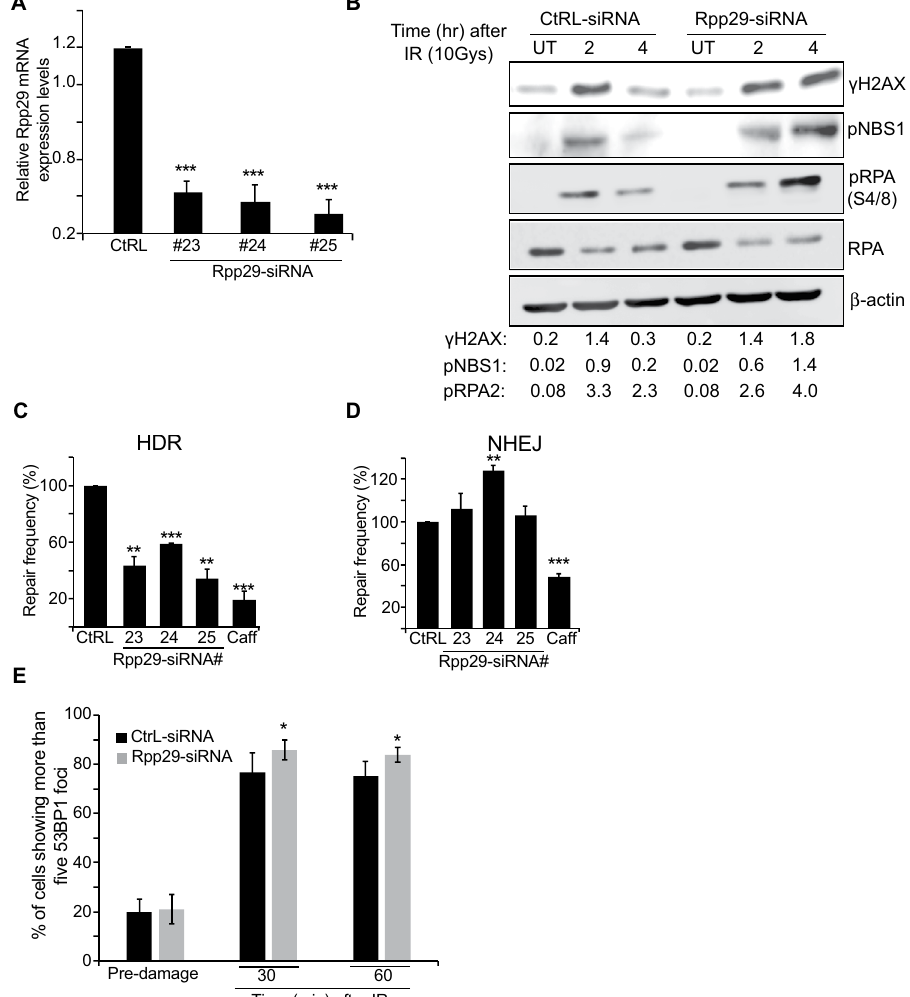
Figure 2. Rpp29 promotes homology-directed repair of double-strand breaks. ( A ) Quantitative real-time PCR shows the efficiency of Rpp29 knockdown in U2OS-TLR cells. Cells were transfected with control siRNA (Ctrl) or three different Rpp29 siRNAs. The y-axis represents the relative Rpp29 mRNA level normalized to that of GAPDH. P-values were calculated by two-sided Student’s t-test relative to Ctrl siRNA; *** p < 0.001. ( B ) Rpp29 knockdown increases IR-induced levels of pRPA2 S4/S8 phosphorylation, γ H2AX, and NBS1 phosphorylation levels. Control and Rpp29-depleted U2OS cells were exposed to IR (10 Gys) and protein extracts were prepared at the indicated time points and subjected to western blot analysis using antibodies directed against the indicated proteins. Total RPA and β -actin were used as internal controls. The bands intensities of γ H2AX, pNBS1 or pRPA were normalized relative to the intensities of their respective β -actin or total RPA bands, respectively. The ratios are shown at the bottom of the blot. Results are representative of two independent experiments. ( C ) Rpp29 knockdown impairs HDR of DSBs generated by I-SceI endonuclease. A reduction of ~50% in GFP-positive cells was observed after Rpp29 depletion. Caffeine was used as a positive control. Results shown are typical of three independent experiments. Error bars represent SD. P-values were calculated by two- sided Student’s t-test relative to Ctrl siRNA; ** and **** indicate significance at P < 0.01 and 0.0001. Given that HDR can occur only in S/G2 cell phase, data were corrected to flow-cytomertry S/G2 values. (D) TLR results for DSBs repair by NHEJ. Rpp29 knockdown had no significant effect on the integrity of NHEJ. Data represents SD for three independent experiments. (E) Percentage of control and Rpp29-depleted cells with more than five 53BP1 foci. Data shown represent at least 300 cells. Two-way ANOVA was used to test for differences at each dose; * p <